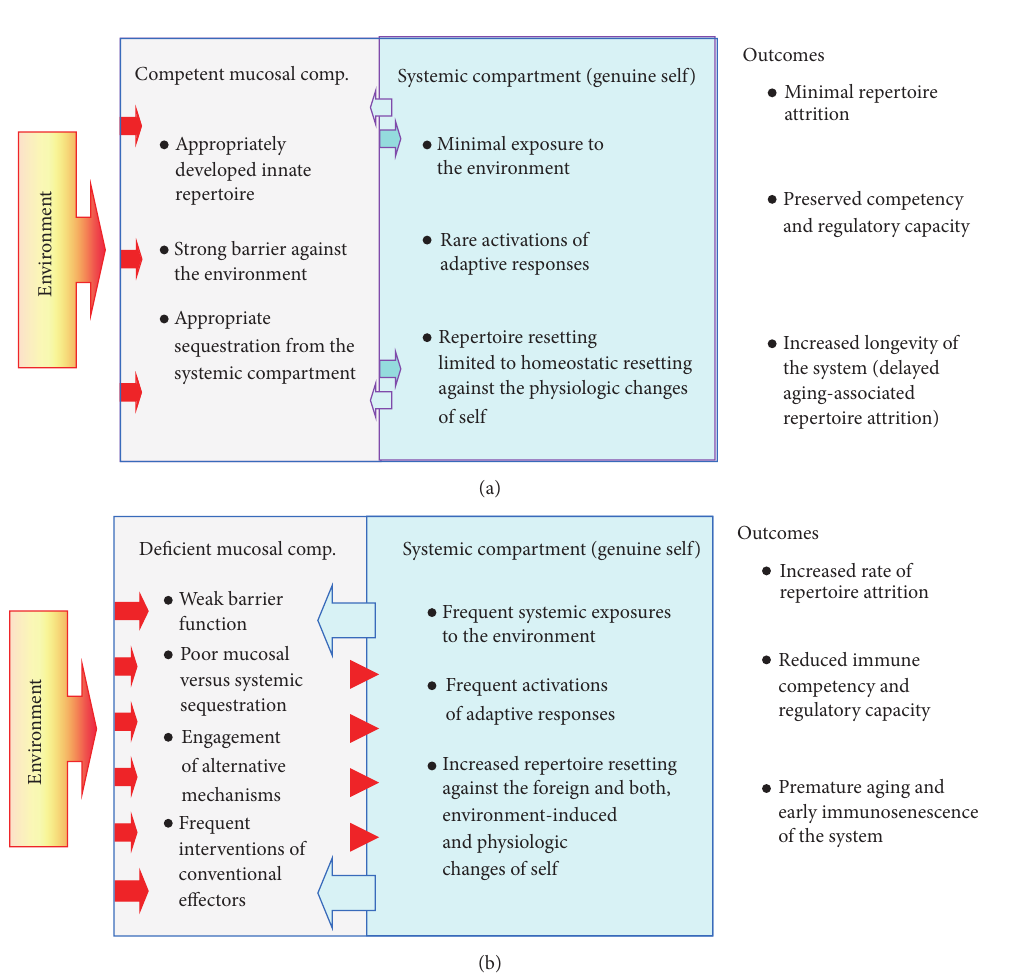
Figure 2: Compartmentalization: competent mucosal immune compartment is essential for appropriate function of the immune system. The CDR concept indicates favorable outcomes in a system with strong mucosal barrier function and appropriately sequestered systemic immune compartment (panel (a)). Panel (b) shows unfavorable outcomes in a system with deficient mucosal barrier function and poorly sequestered systemic immune